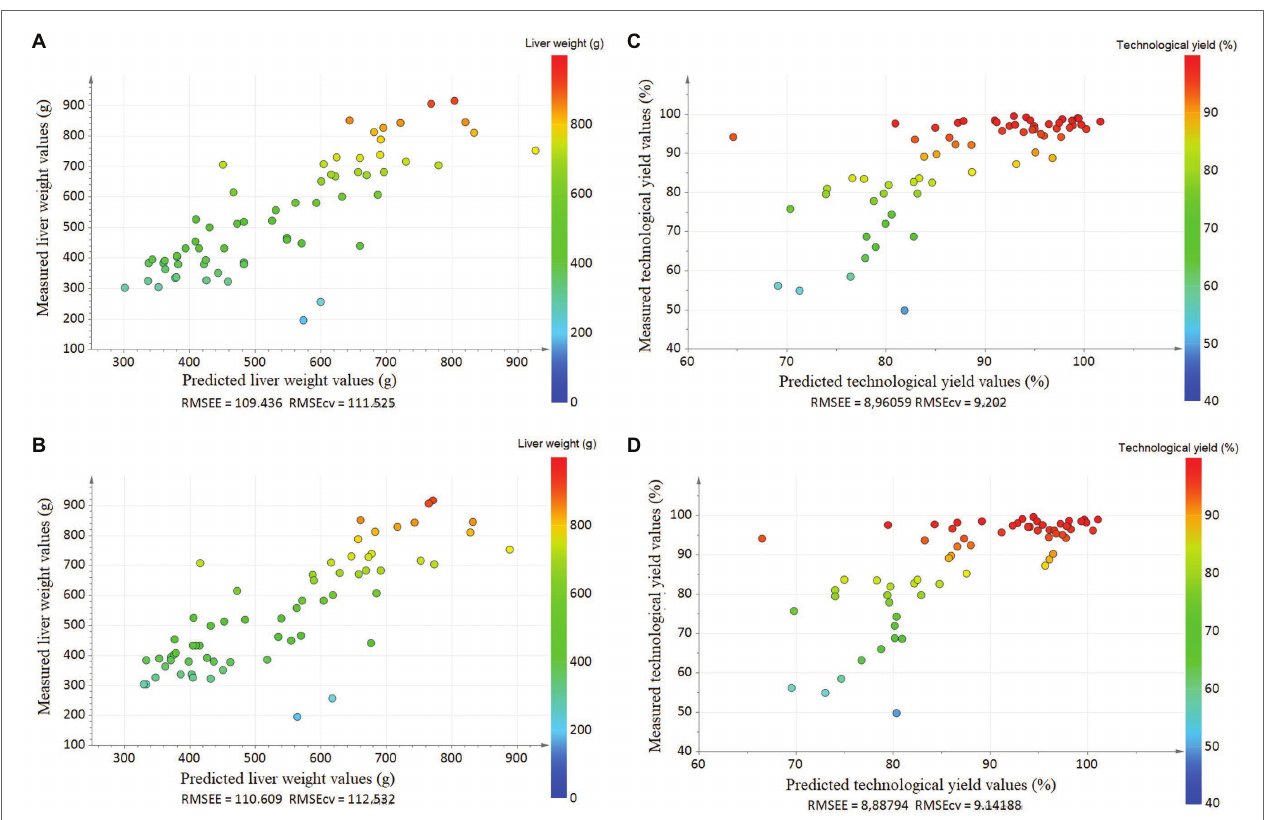
FIGURE 4 | Plots of predicted vs. observed data (A) for liver weight with the bucket method, (B) for liver weight with the metabolite method, (C) for liver technological yield with the bucket method, and (D) liver for technological yield with the metabolite method. The Root Mean Square Error of Estimation (RMSEE) and the Root Mean Square Error after cross validation (RMSECv) were